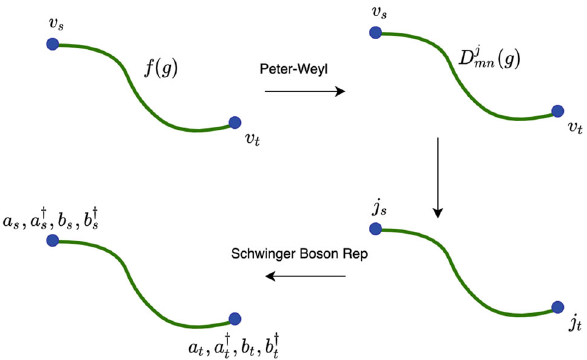
Fig. 3 Illustration of steps leading from cylindrical functions of edge holonomies to Schwinger Boson basis with pairs of ladder operators assigned to the source and target vertices